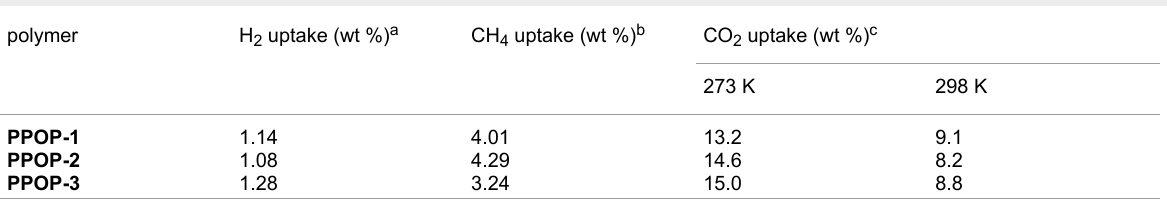
Table 2: Gas adsorption uptake of PPOP-1 – PPOP-3 .